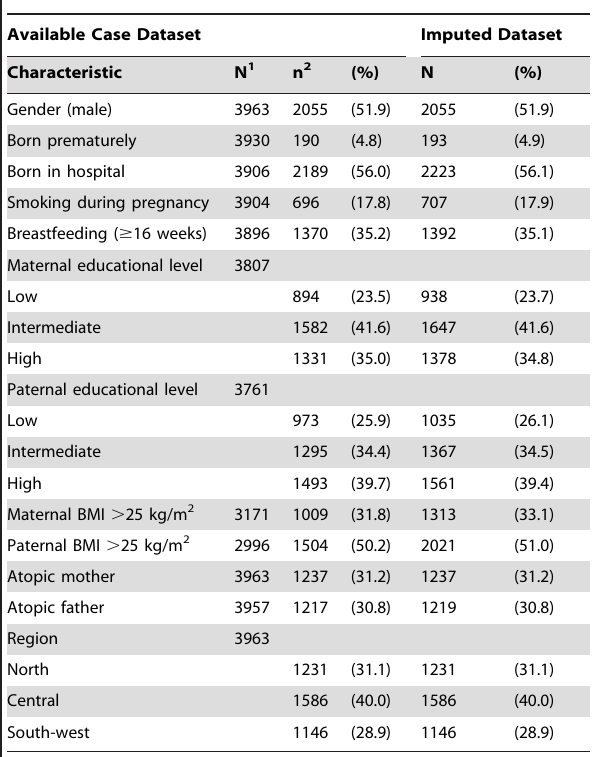
Table 1. Characteristics of the study population for